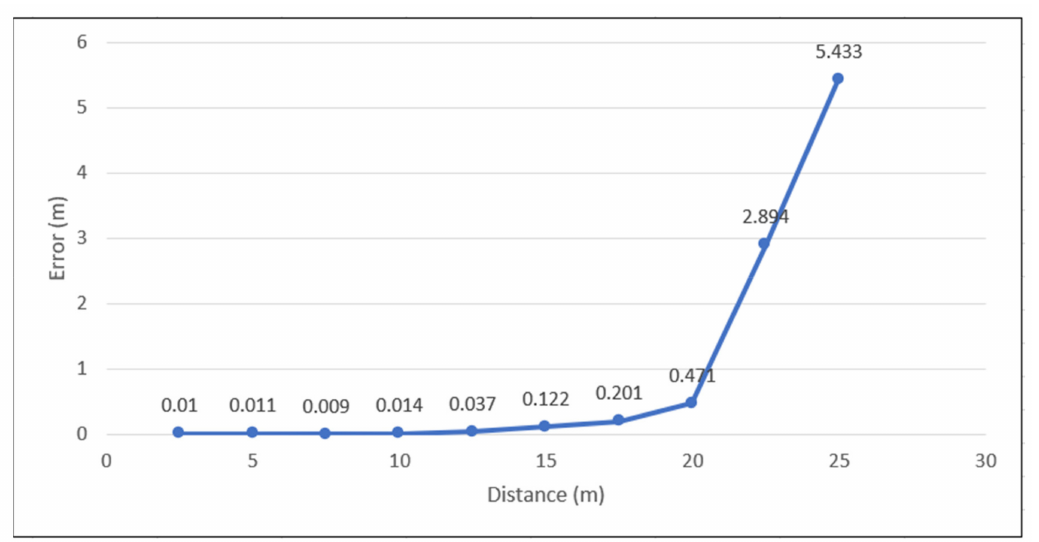
Figure 9. Location error obtained for the self-collected